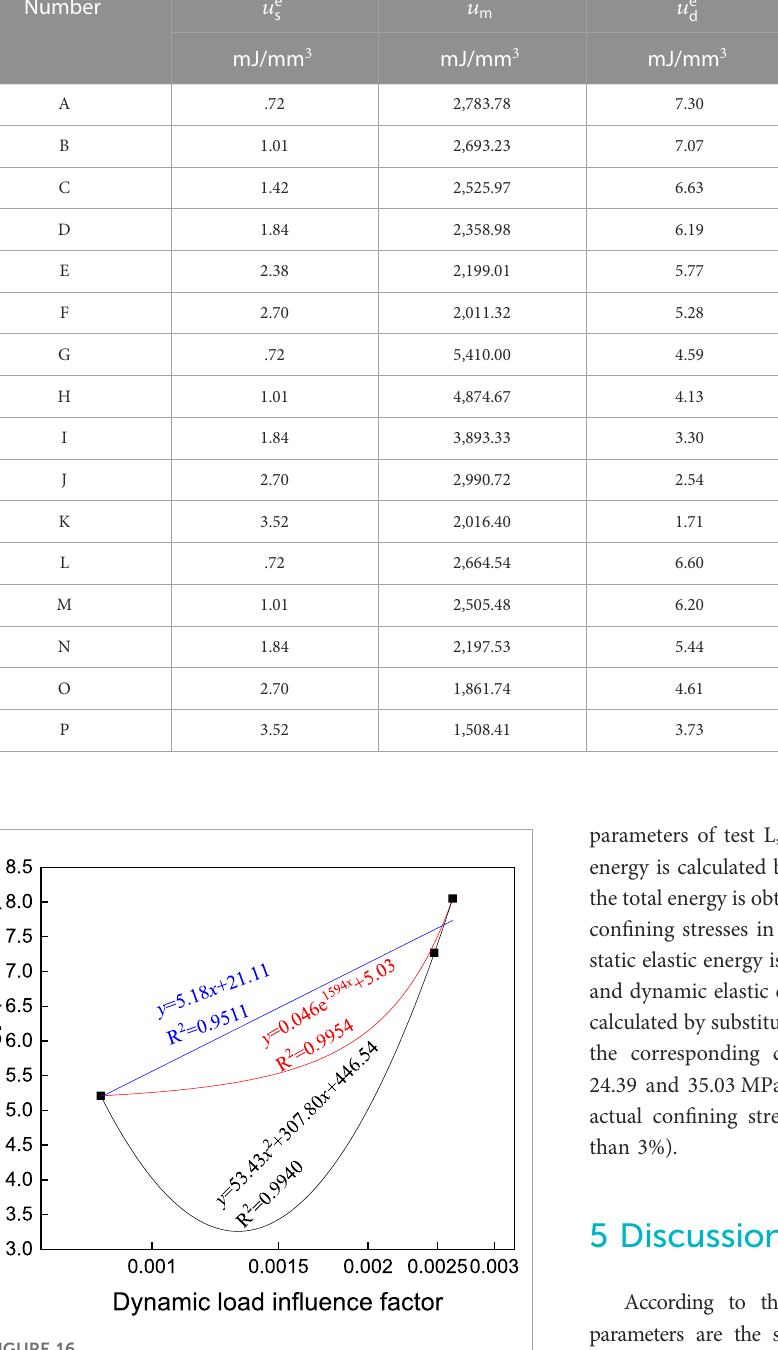
FIGURE 16 Relationship between the total energy in the rock and dynamic load in fl uence